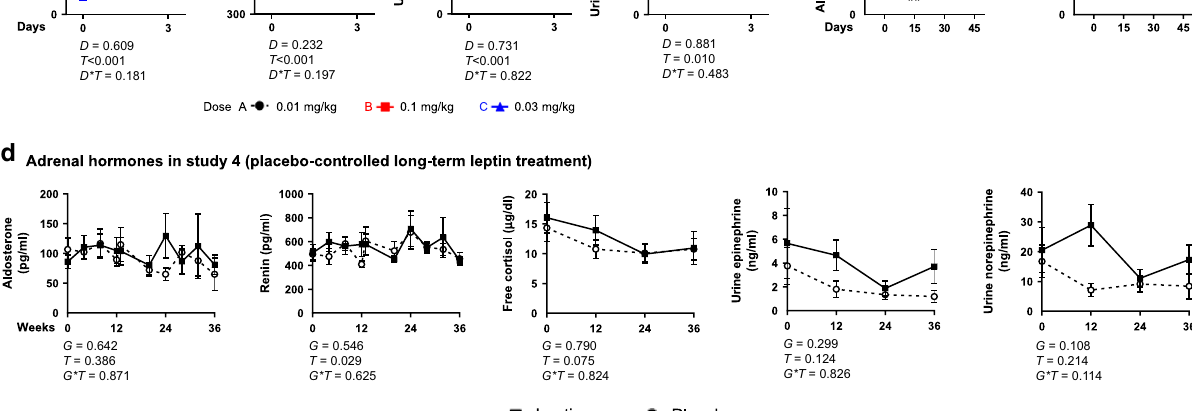
conditions (leptin or placebo-treated), component 1 consisting of ten parameters discriminated progressively between the different days of fasting but not between placebo or leptin (in Fig. 6c, faint colors (days 0 – 1 of fasting) are gathered at the right (area of positive values for component 1) and bright colors (days 2 – 3 of fasting) at the left (area of negative values for component 1), whereas the circles (leptin) and the squares (placebo) are equally distributed from right to left). Component 1 included classic milestones of metabolic adaptation during starvation, such as amino acids and ketone bodies that their concentrations change (Supplementary Fig. 5a, b). This shows that blocking hypolepti- nemia does not prevent the shift from carbohydrates to lipid